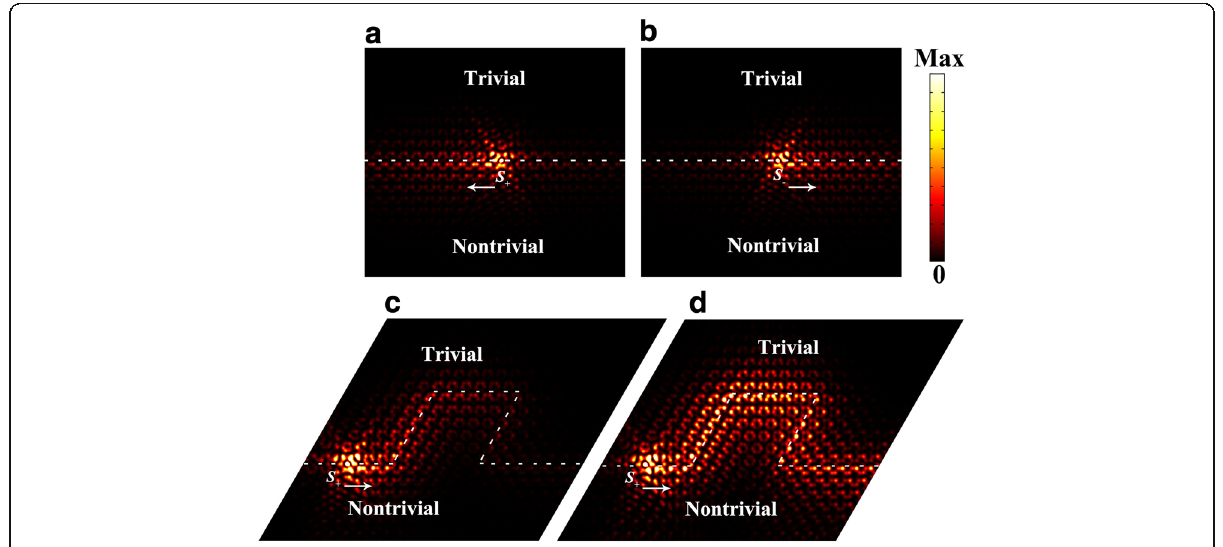
Fig. 4 a Leftward and b rightward one-way edge states excited by in-plane magnetic field with a π /2 phase difference: S (cid:4) ¼ H 0 ð x * ∓ i y * Þ . c Topological edge states traveling along sharp bends. d The electric field intensity distribution of the topological one-way transmission without considering the intrinsic loss of graphene